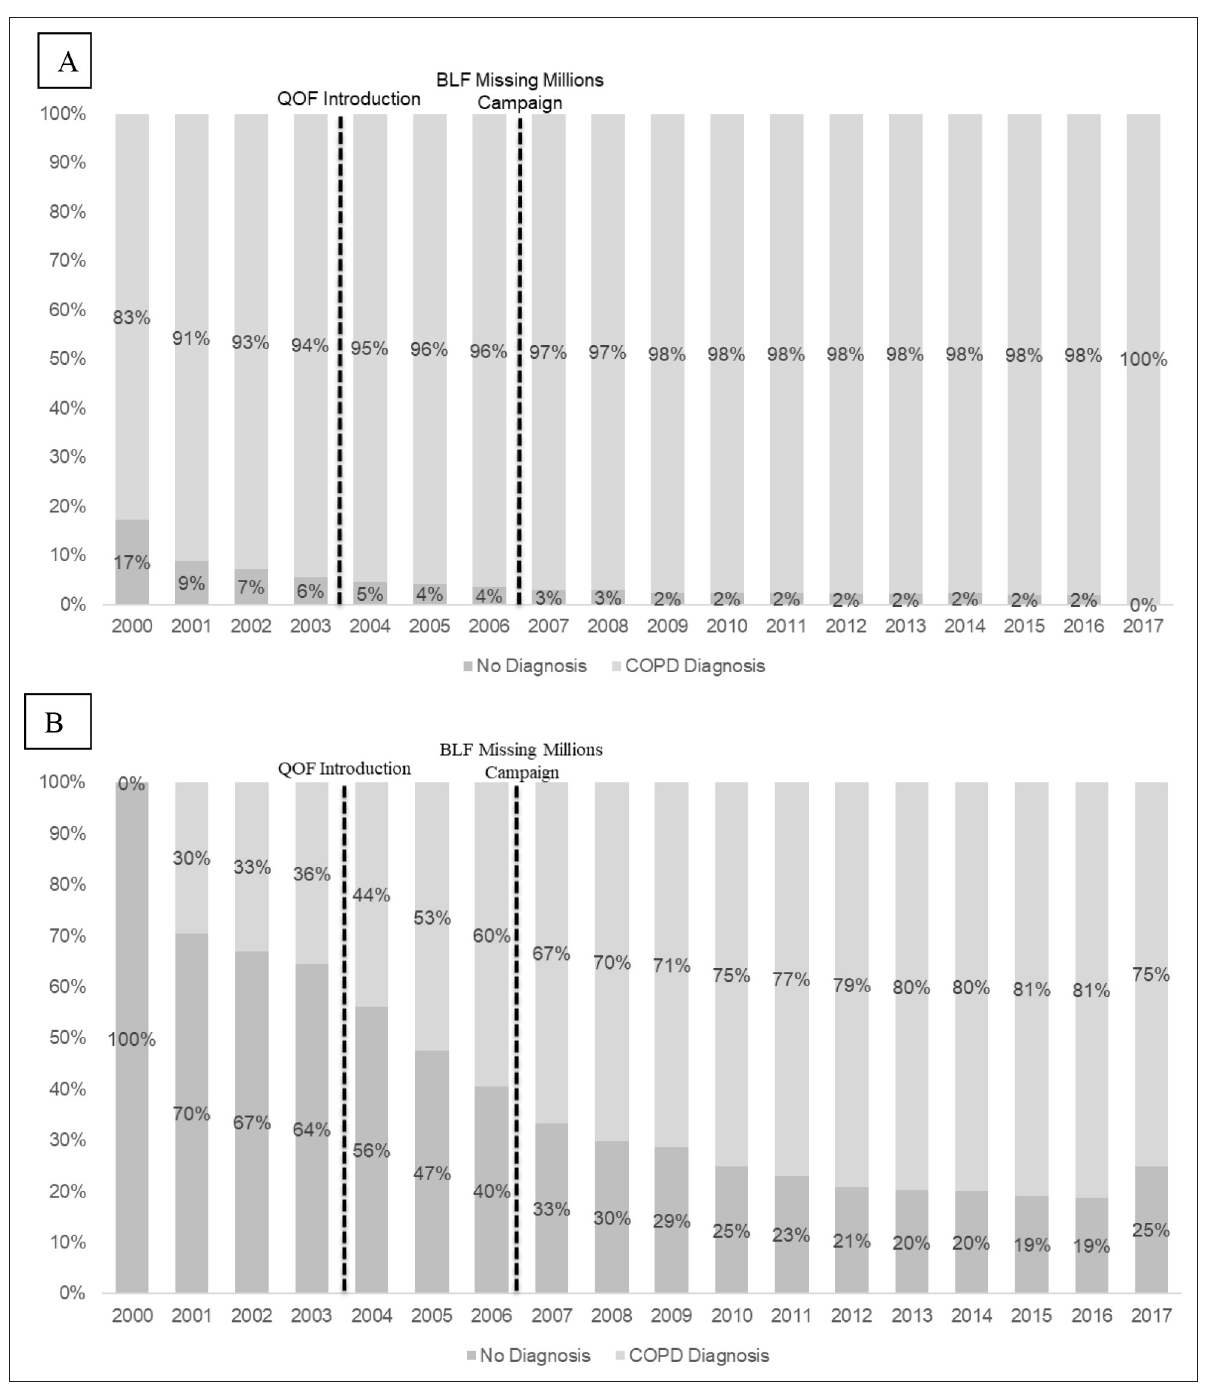
Figure 3 Proportion of patients with a missed COPD diagnosis by year of death (panel A shows definition A, panel B shows definition E). BLF = British Lung Foundation. COPD = chronic obstructive pulmonary disease. QOF = Quality and Outcomes